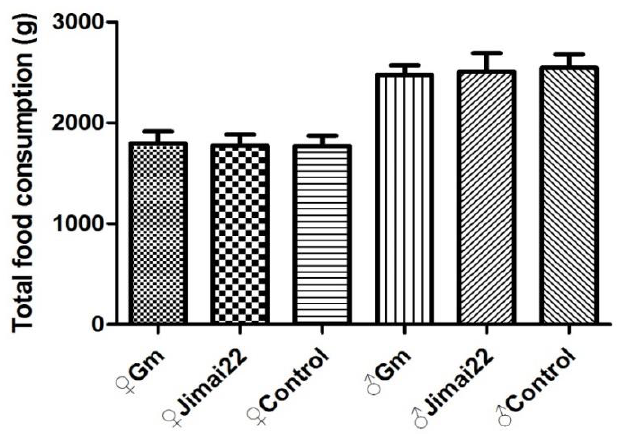
compared with control group.